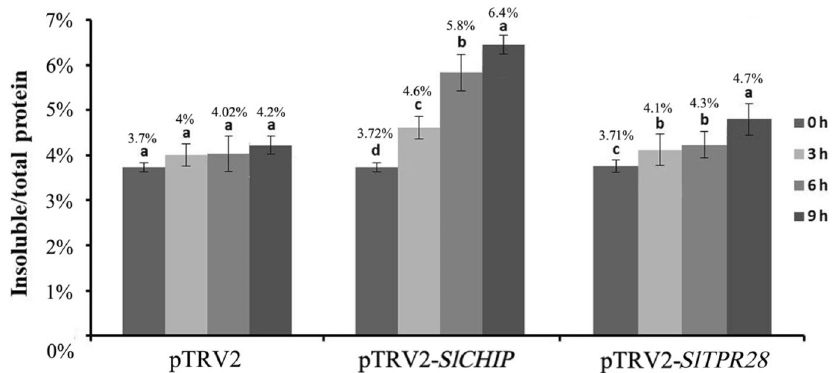
Figure 6. Accumulation of insoluble protein aggregates in SlCHIP - and SlTPR28 -silenced plants under heat stress. Leaf tissues from mock (pTRV2)-, SlCHIP -silenced (pTRV2- SlCHIP ) and SlTPR28 -silenced (pTRV2- SlTPR28 ) plants were collected at indicated hours at 45 °C for extraction of total, soluble and insoluble proteins as described in Materials and Methods. The starting homogenates as total proteins and the last pellets as insoluble proteins were determined and the percentages of insoluble proteins to total proteins were calculated. Error bars indicate SE (n = 12). According to Tukey’s multiple comparisons test ( P = 0.01), means do not differ significantly if they are indicated with the same letter. Experiments were repeated three times with similar